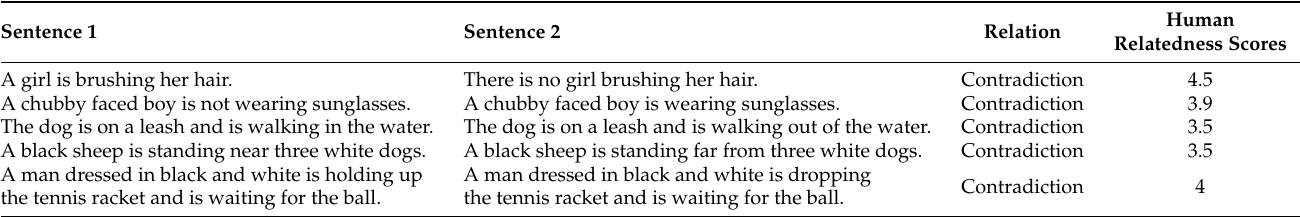
Table 6. Example sentence pairs of the SICK [64] test-split data with the contradiction relation, which have high human relatedness